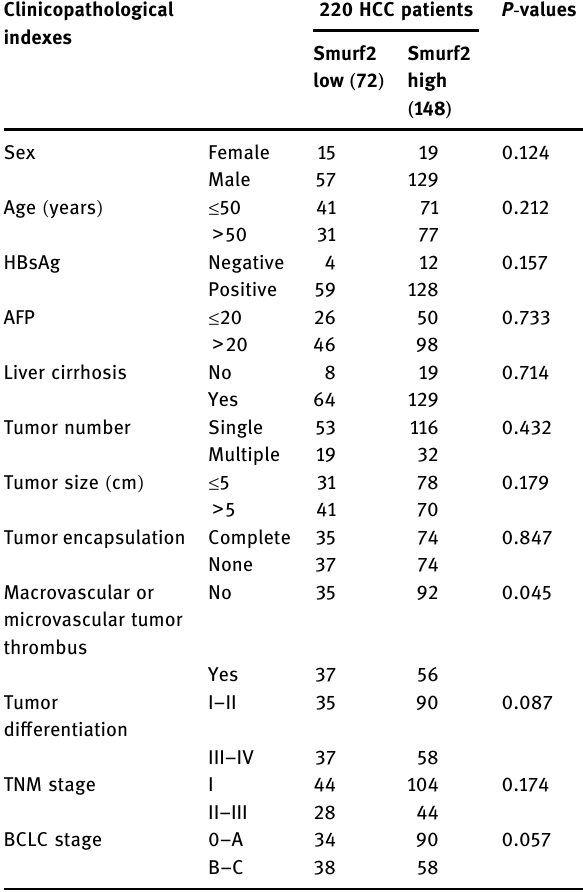
Table 1: Clinical characteristics of 220 HCC patients